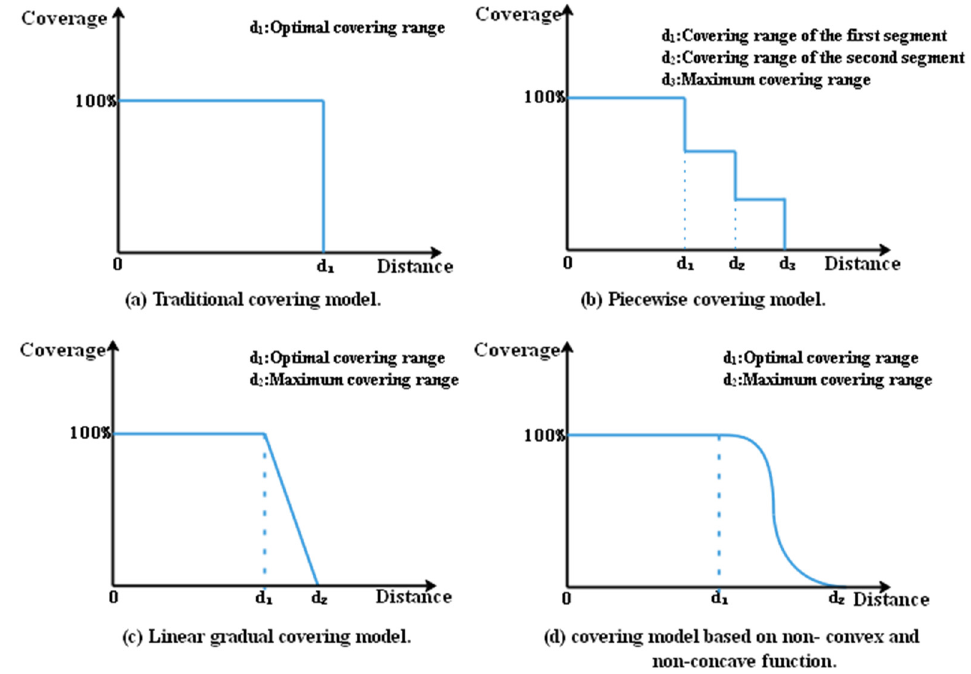
Figure 4. Schematic diagram of different covering models.